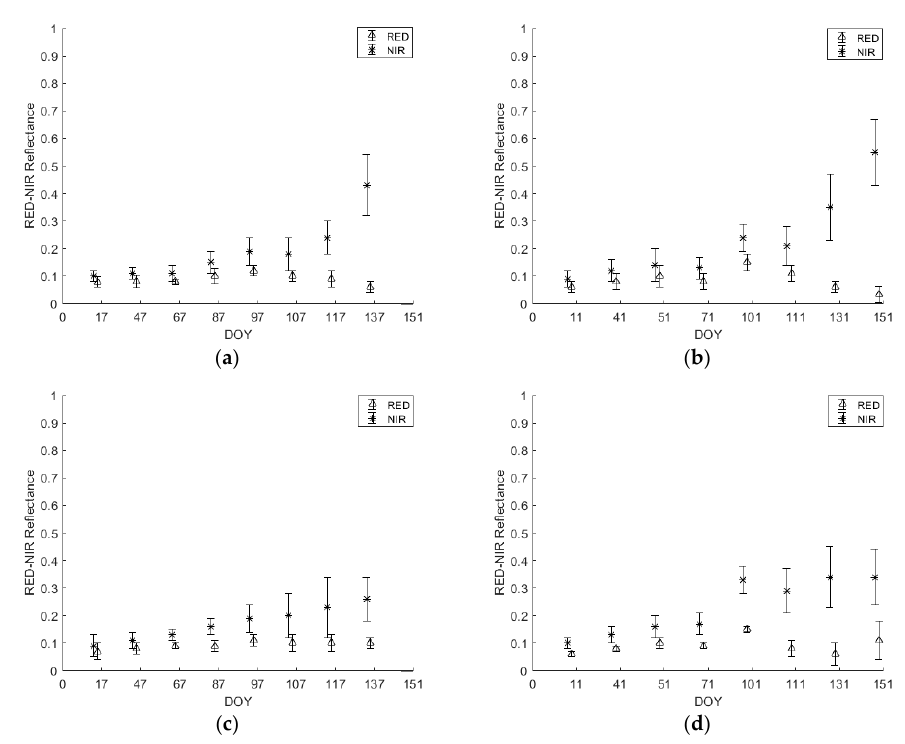
Figure 6. Mean ± standard deviation of RED and NIR temporal profiles of spring potato ( a ) 2016 and ( b ) 2017 and spring vegetables ( c ) 2016 and ( d ) 2017.